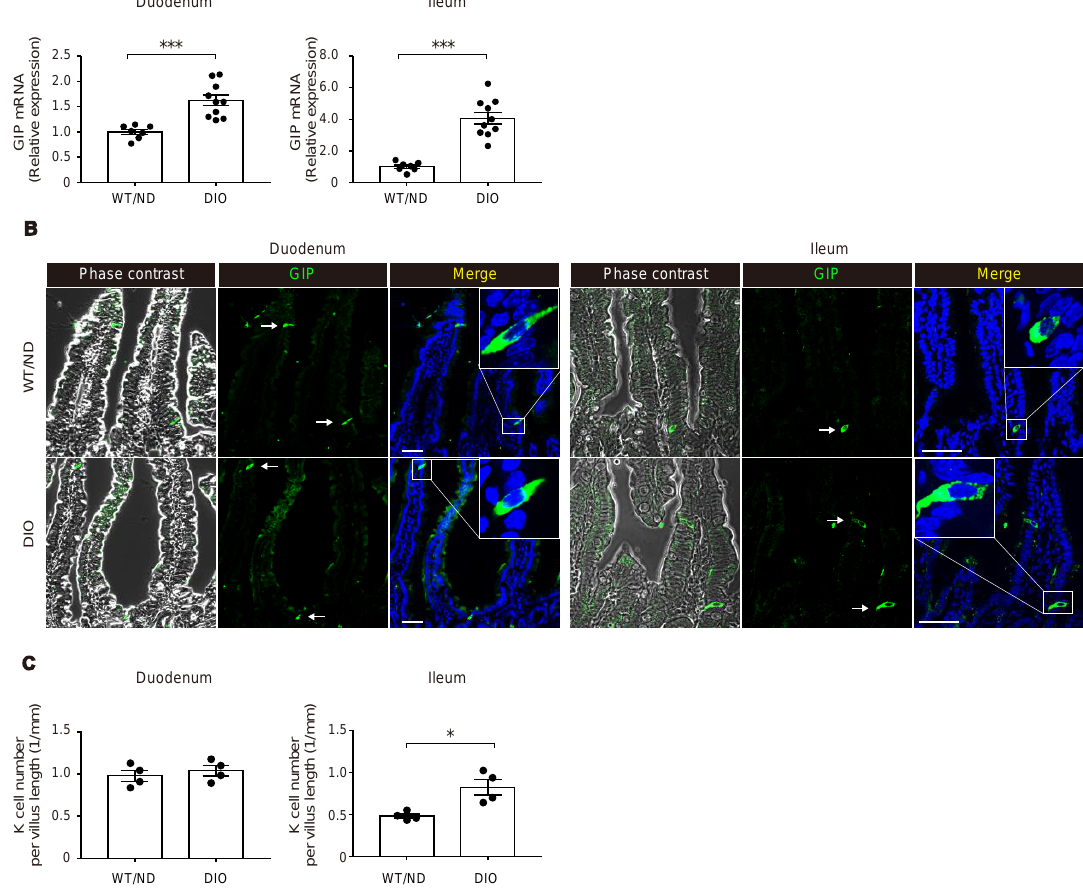
Figure 2. Changes in GIP expression and K cell number by HFD. A : Messenger RNA expression of GIP in the duodenum (left) and the terminal ileum (right) was examined in WT/ND and DIO mice by quantitative real-time polymerase chain reaction (qPCR) analysis. ( B , C ) Immuno-histochemical images of GIP-positive K cells ( B ) and quantification of K cell number ( C ). ( A , C ) Each data point is plotted as a circle. Bars depict mean ± SEM. * p < 0.05, *** p < 0.001. ( B ) Bars indicate 50 μm.